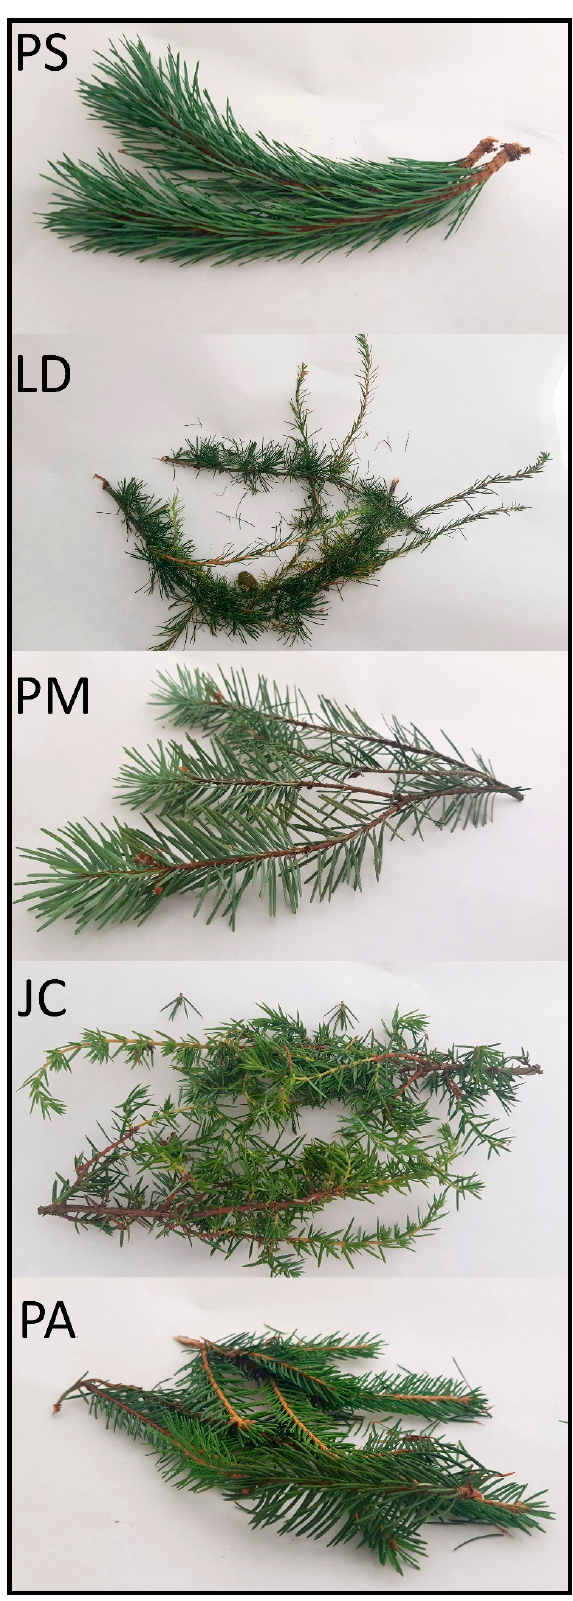
Figure1. Freshconifer shoots. Abbreviations: Picea abies L. (PA), Larix decidua Mill (LD), Pinus sylvestris L. (PS), Pseudotsuga menziesii (PM) and Juniperus communis L.